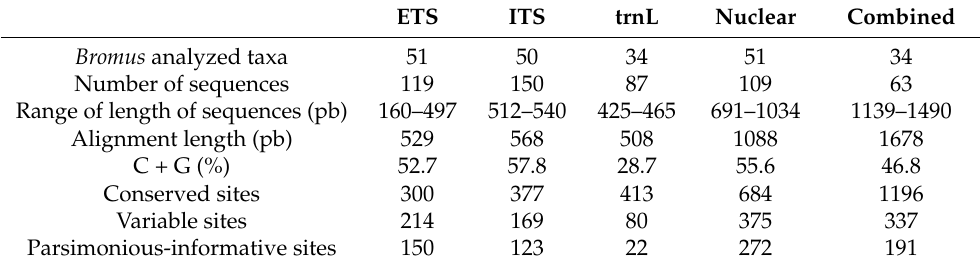
Conserved sites 300 377 Variable sites